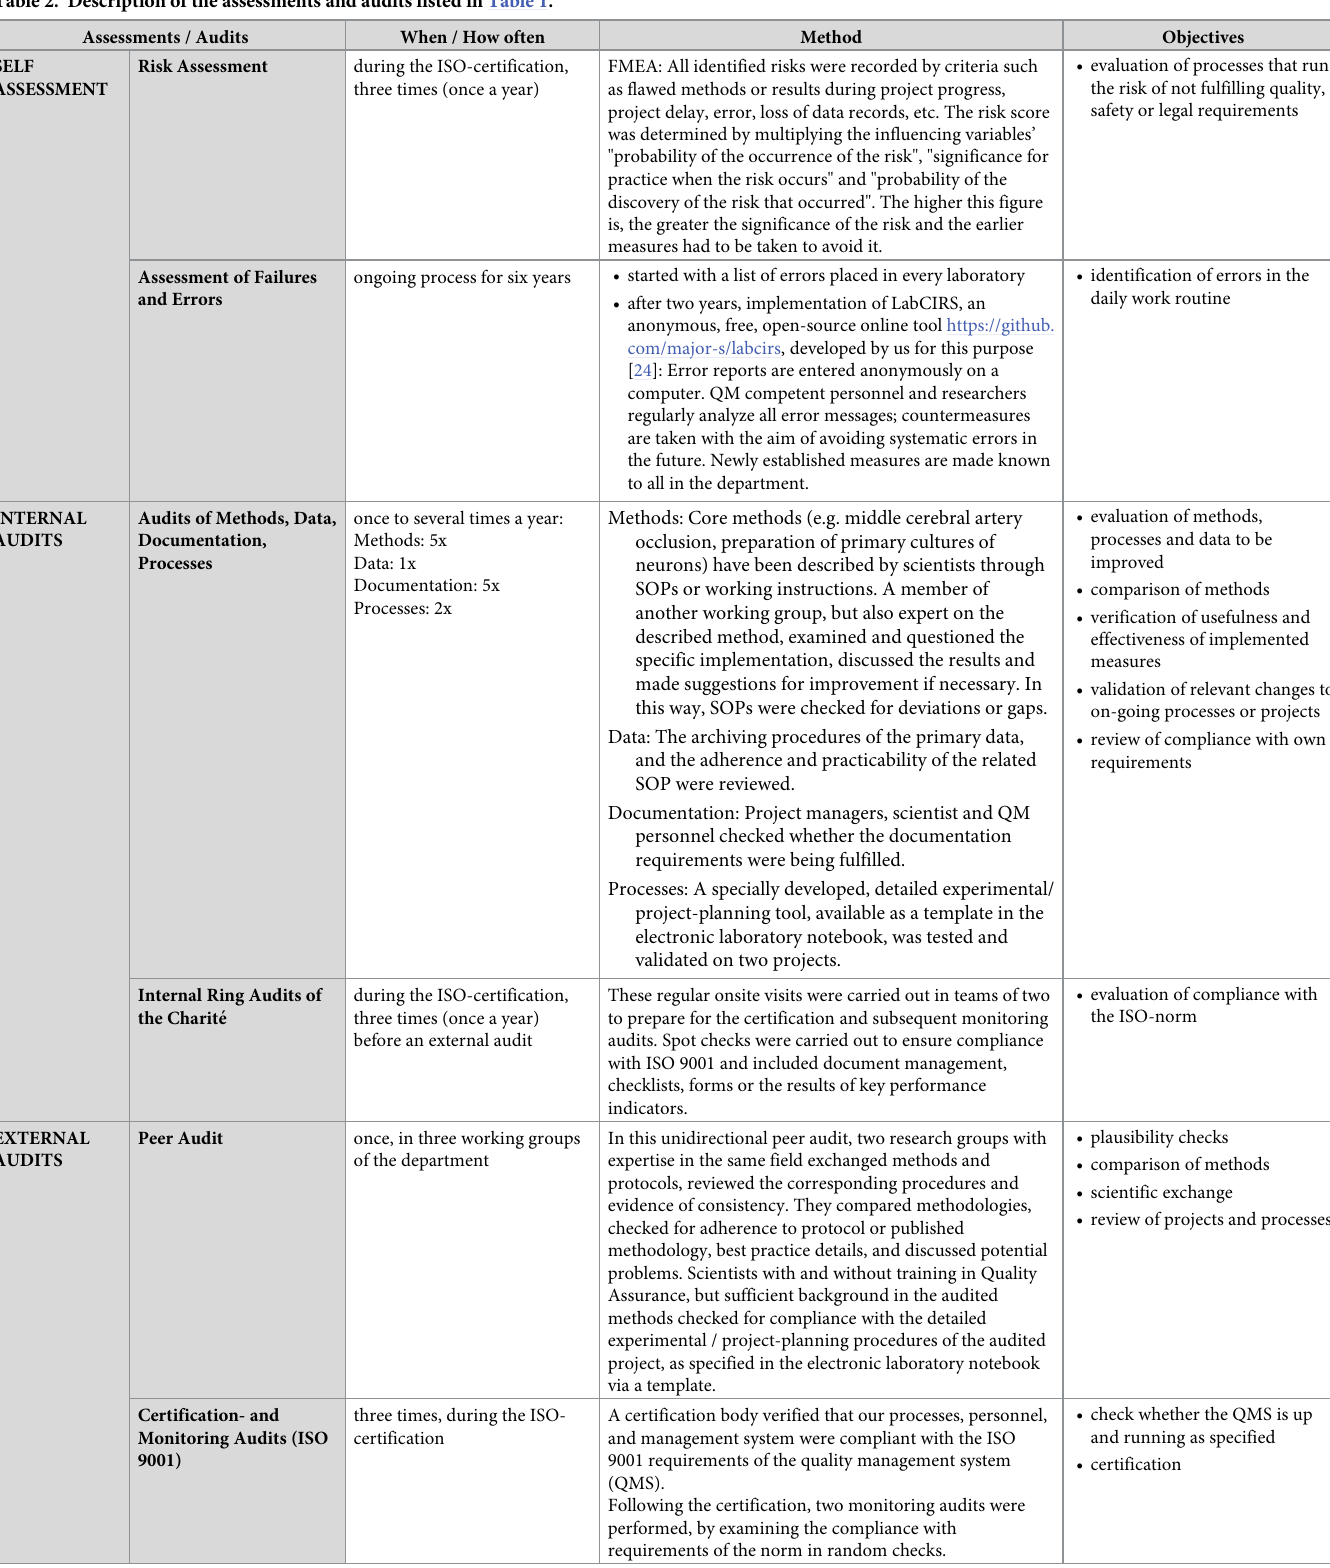
Table 2. Description of the assessments and audits listed in Table